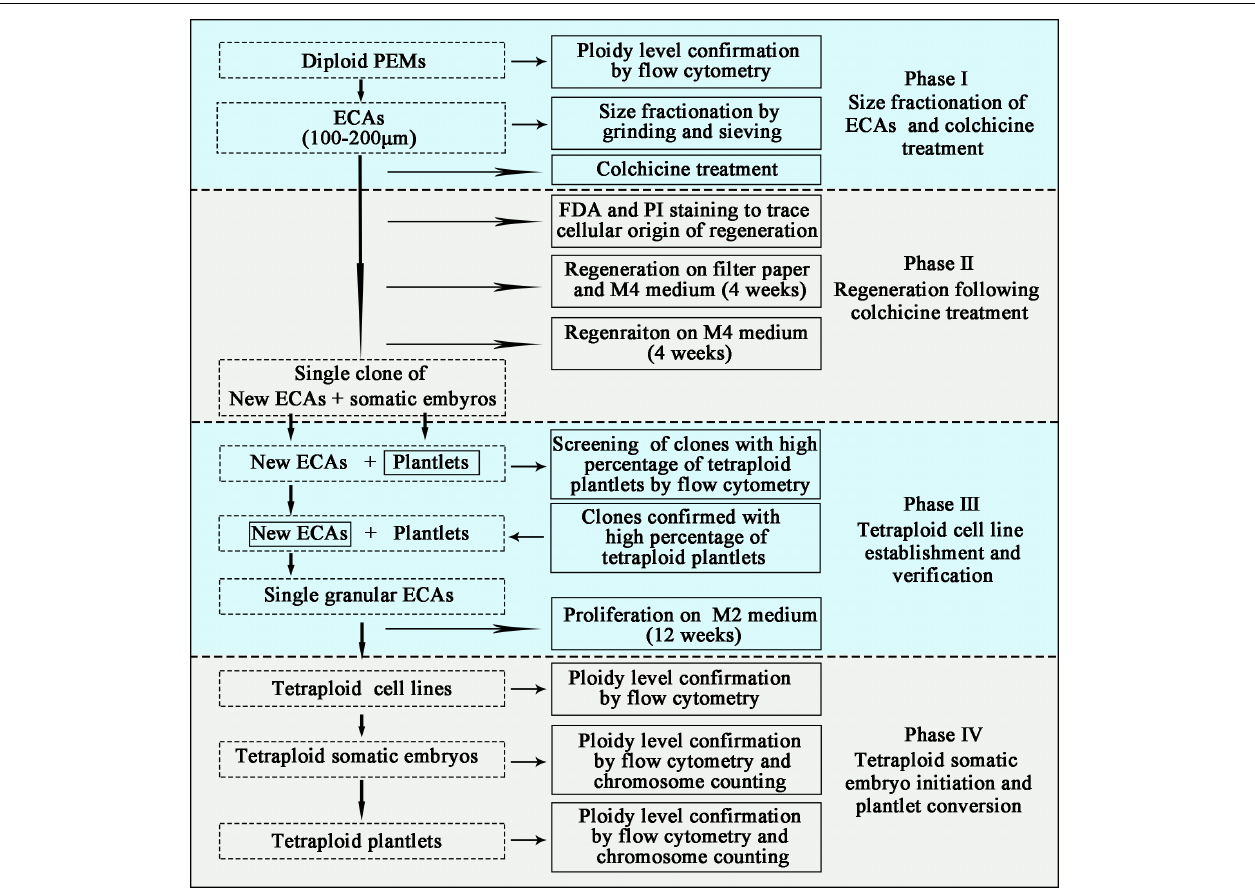
FIGURE 2 | Schematic pipeline for the establishment of tetraploid cell lines of Magnolia officinalis . Sequential stages of colchicine treatment, regeneration, tetraploid cell line establishment and ploidy level verification are